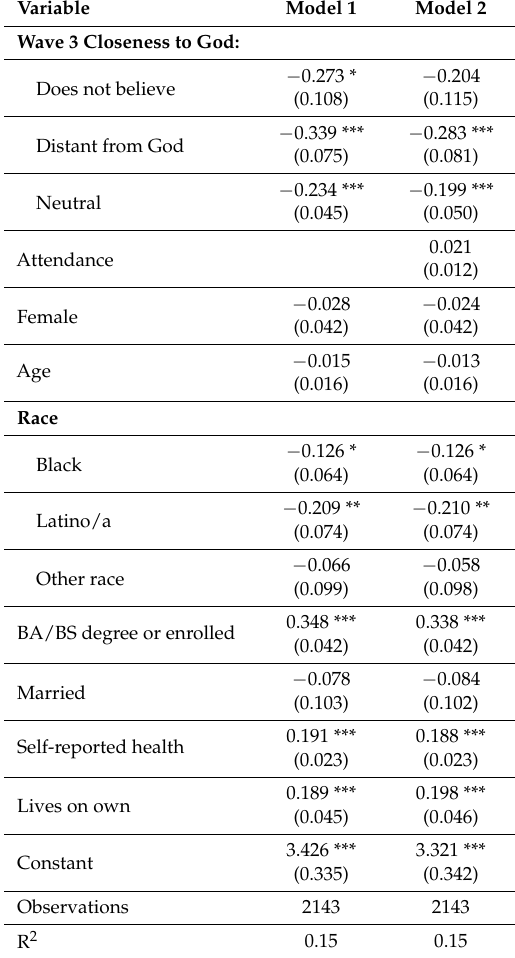
Table 2. Wave 3 Life Purpose Regressed on Wave 3 Closeness to God and